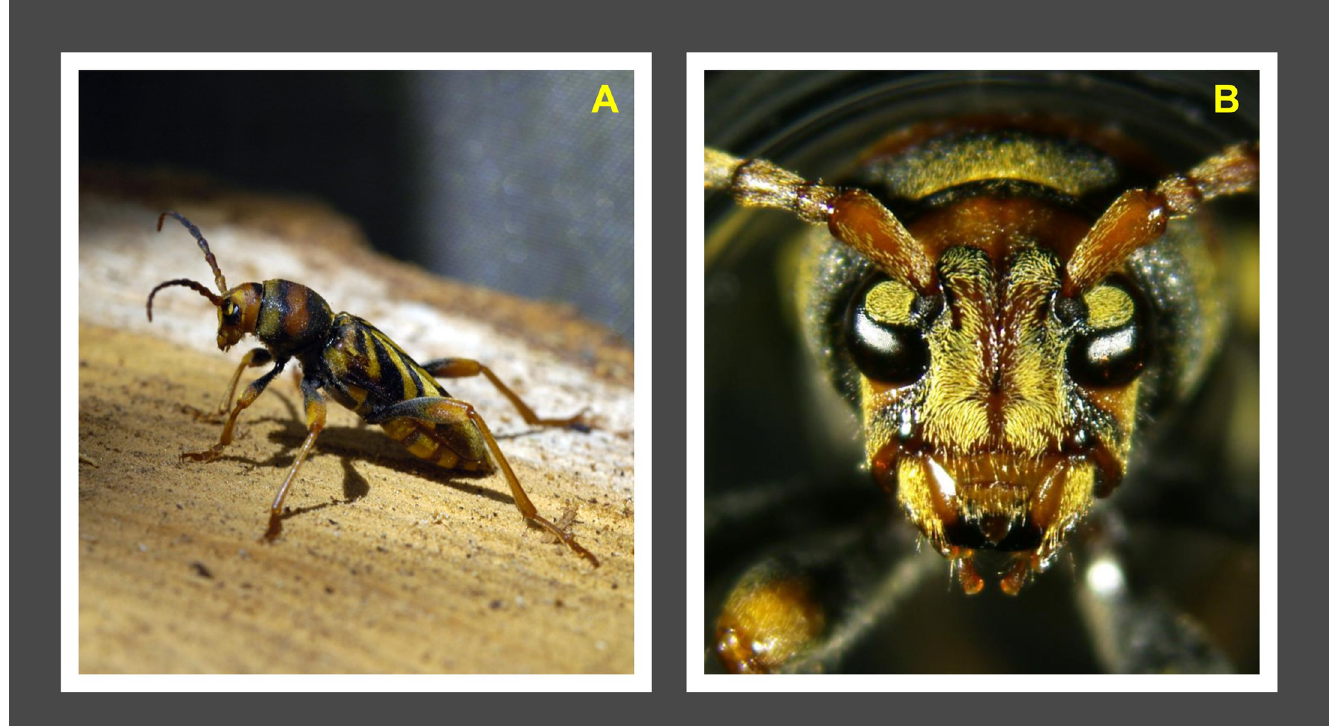
Fig 1. A male of Xylotrechus chinensis . (A) Posing alert on a mulberry bolt. (B) Close-up of male head. (Photos V. Sarto i